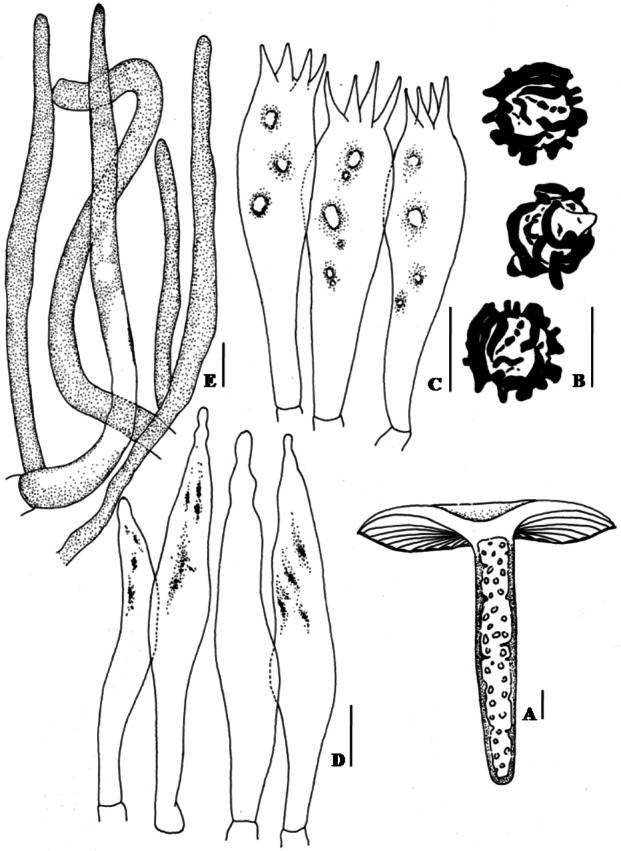
Hand drawing of macro- and microscopic characters of Russula seneceis.(A) Fresh basidiomata showing stipe context. (B) Basidiospores. (C) Basidium. (D) Hymenial cystidia. (E) Pileocystidia. Bars (A): 1 mm; (B–E): 10 µm.